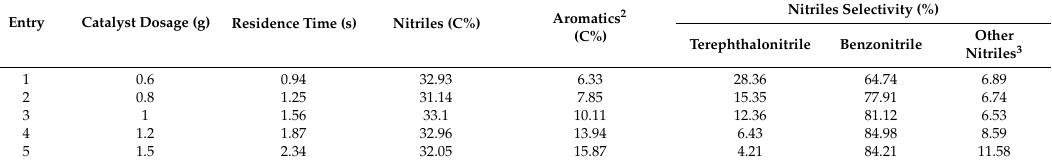
Table 3. E ff ect of residence time between pyrolytic vapors and catalyst.